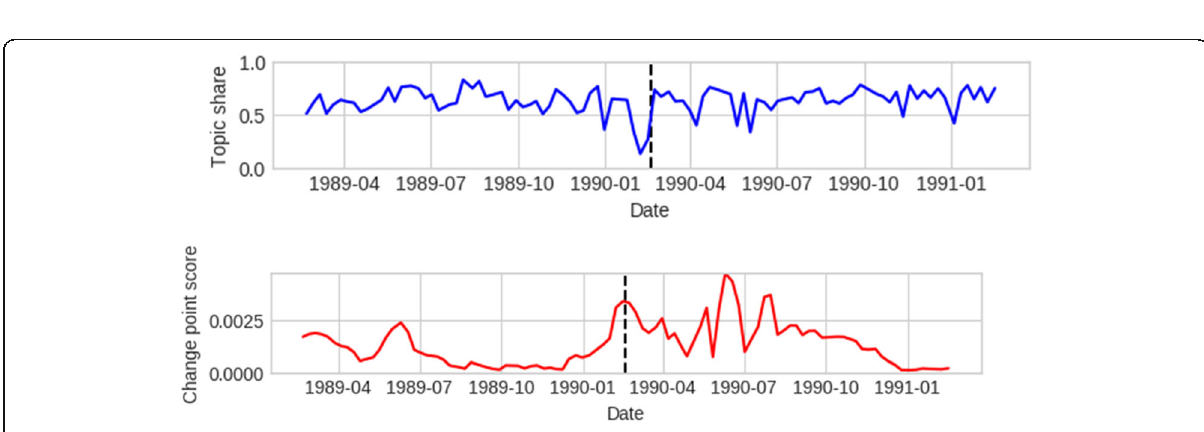
Fig. 13 Topic share and change point score of economic policy topics